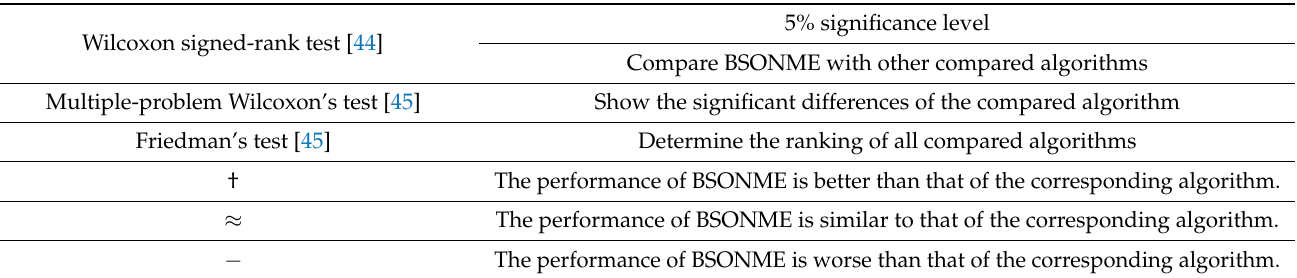
Table 3. Performance measure used in the